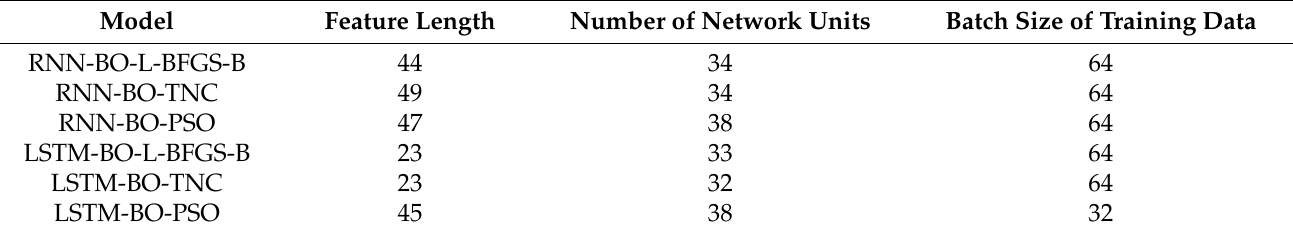
Table 3. The hyper-parameters of each